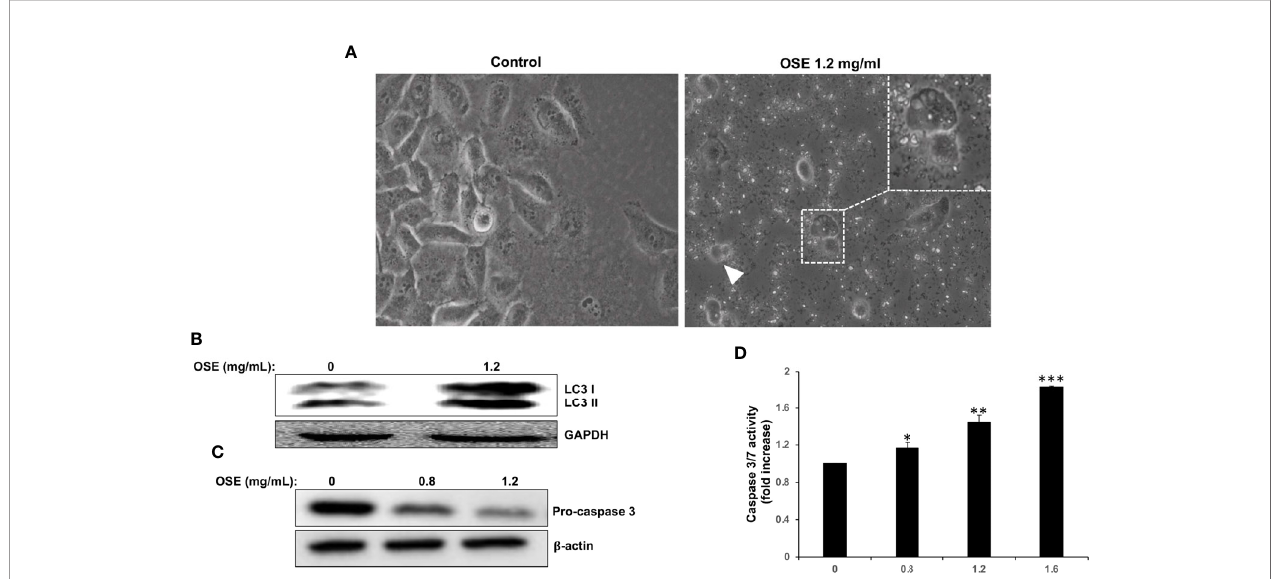
FIGURE 2 | OSE induces autophagy and apoptosis in MDA-MB-231. (A) Cells were treated with OSE (1.2 mg/ml) for 48 hrs. Micrographs were captured at magni fi cations of 200X. (B) Induction of autophagy by OSE. Cells were treated with OSE (1.2 mg/ml) for 48 hrs, and cytoplasmic (LC3 I) and lipidized LC3 II accumulation was detected by Western blotting. (C) Activation of apoptosis by OSE. Cells were treated with OSE (0.8 and 1.2 mg/ml) for 48 hrs, and cleavage of procaspase-3 was examined by Western blotting. (D) Cells were treated without (0) or with OSE (0.8, 1.2 or 1.6 mg/ml) for 24 hours, and then Caspase 3/7 activity measured. (* denotes p<0.05, ** denotes p<0.01, and *** denotes